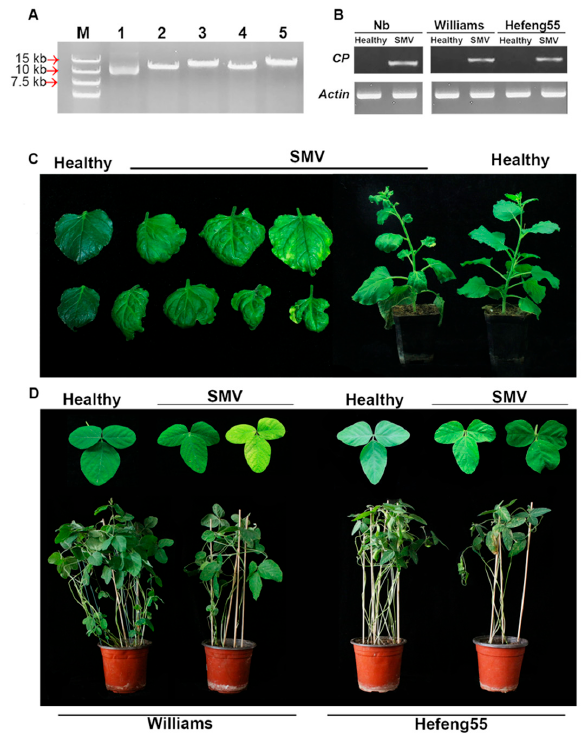
Figure 1. Infectivity of Soybean mosaic virus (SMV) derived from the pLXB-SMV infectious clone in N. benthamiana and soybean. ( A ) Confirmation of the pLXB-SMV infectious clone by restriction endonuclease digestion. M: DL15000 marker. Lane 1: plasmid control without enzyme digestion. Lanes 2–5: individual recombinant plasmids digested with Sal I. ( B ) RT-PCR analysis of SMV via coat protein region (CP)-specific primers in N. benthamiana and soybean leaves at 12 days post